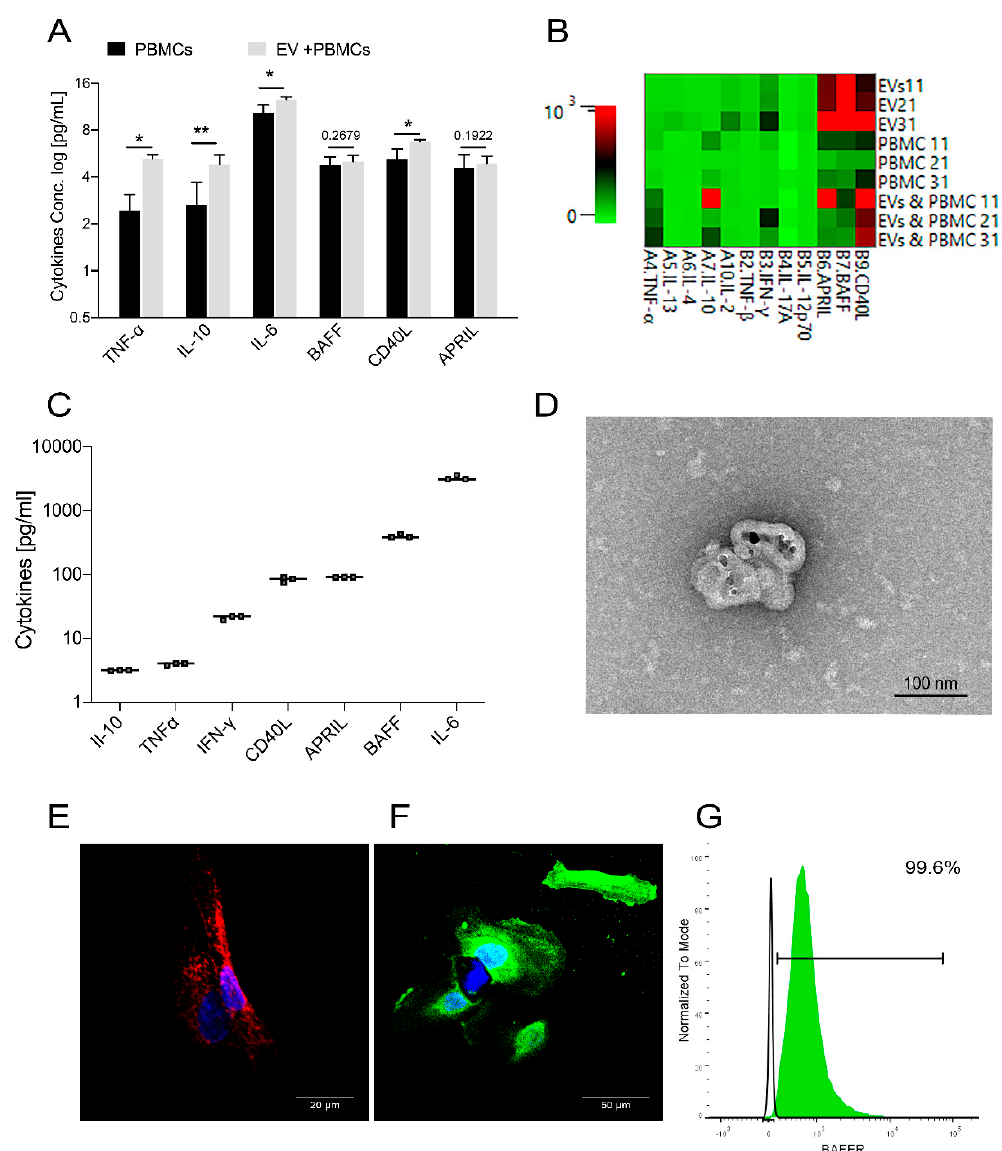
Figure 5. Cytokines Analysis of the EVs; ( A ) Cytokines analysis of EV co-culture supernatant run by Biolegend plex assay shows a significant increase in IL6, CD40L, IL10, and TNF α in response to EV co-culture ( n = 3). ( B ) Heat map of the EV lysates, PBMCs, and the co-culture for cytokines concentration generated by Bio–legendplex software. ( C ) Cytokines analysis of 10 µ g/mL EV lysates shows the expression of considerable amounts of IL–6, BAFF, APRIL, CD40L, and traces of IL–10, TNF α , and IFN– γ ( n = 3). ( D ) Immune gold staining of the isolated vesicles for CD40L using 6 nm gold nanoparticles (Mic. Mag. × 23,000, 2% Uranyl Acetate). ( E ) Confocal microscope image of DAPI (blue) stained USC after permeabilization for CD40L mAb (red) (Mic. Mag. × 600, scale bar = 20 µ m). ( F ) Confocal microscope image of DAPI (blue) stained USCs after staining with BAFFR mAb (green) (Mic. Mag. × 600, scale bar = 50 µ m). ( G ) Flow cytometry analysis of 10 4 USCs for BAFFR expression showing 99% positive cells (green shaded histogram) in relation to the isotype control (non–shaded histogram), representative sample. Values are presented as mean ± SEM and p–values were determined by paired Student’s t –tests. Cytokines data are prior to log treatment. * p < 0.05, ** p <